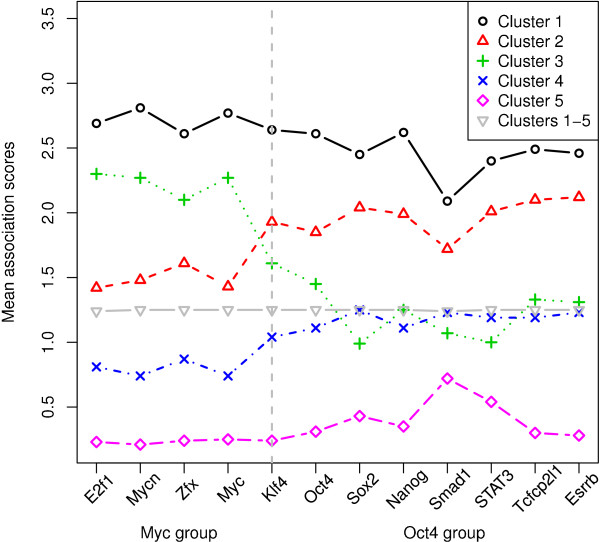
Mean association scores of gene clusters. Each data point in the figure indicates the mean of the association scores of a cluster of genes for a TF. The vertical broken line separates the Myc group and the Oct4 group. "Clusters 1-5" indicates the grand mean scores of all the genes for a TF.